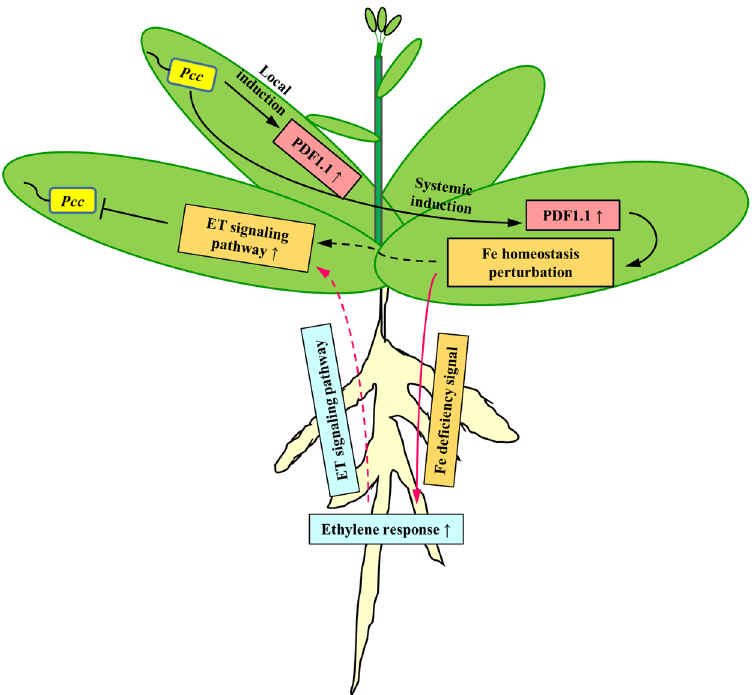
Figure 7. A proposed model of AtPDF1 . 1 -mediated defence response to the infection by Pcc . During Pcc infection, transcription of AtPDF1 . 1 is upregulated in both the local infected and systemic non-infected leaves. The production of AtPDF1.1 protein leads to the chelation/restriction of iron availability in the apoplast, and the consequent perturbation of iron homeostasis. This results in the activation of an iron deficiency response in leaves and the subsequent activation of the ethylene (ET) biosynthesis and signalling pathway in roots. This in turn causes the systemic activation of a jasmonic acid (JA)/ET-mediated immune response in leaves, which promotes tolerance to the infection of necrotrophic